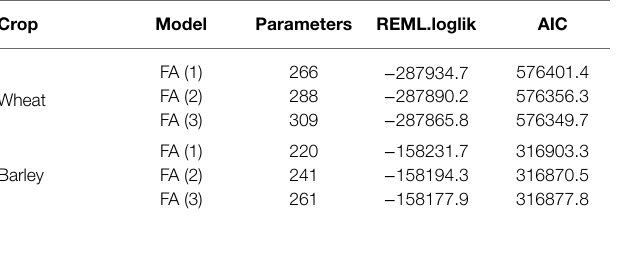
TABLE 5 | Summary of models fitted FA (1), FA (2), and FA (3) including the number of parameters, residual maximum log-likelihood (REML.loglik) and Akaike information criterion